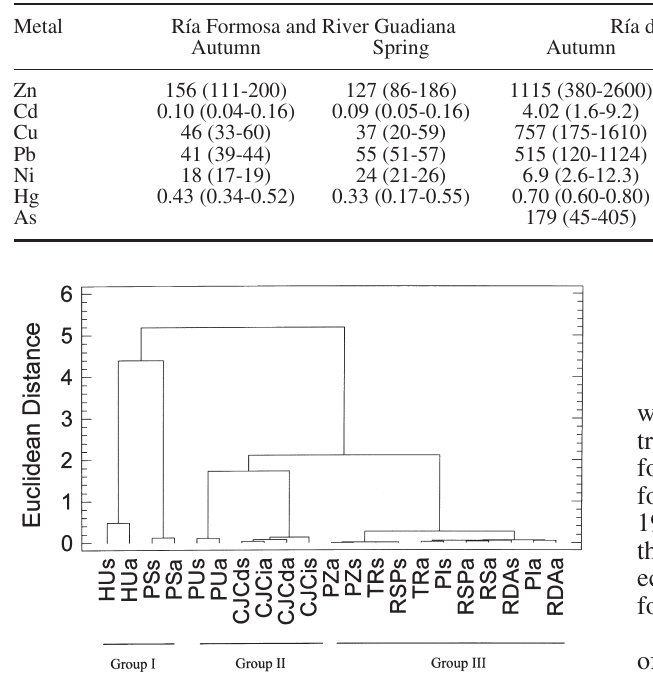
Fig . 4. – Dendrogram showing clustering of sampling sites (Group I, sampling stations HU and PS; Group II, sampling stations PU, CJCd and CJCi; Group III, PZ, TR, RSP, RA, RDA and